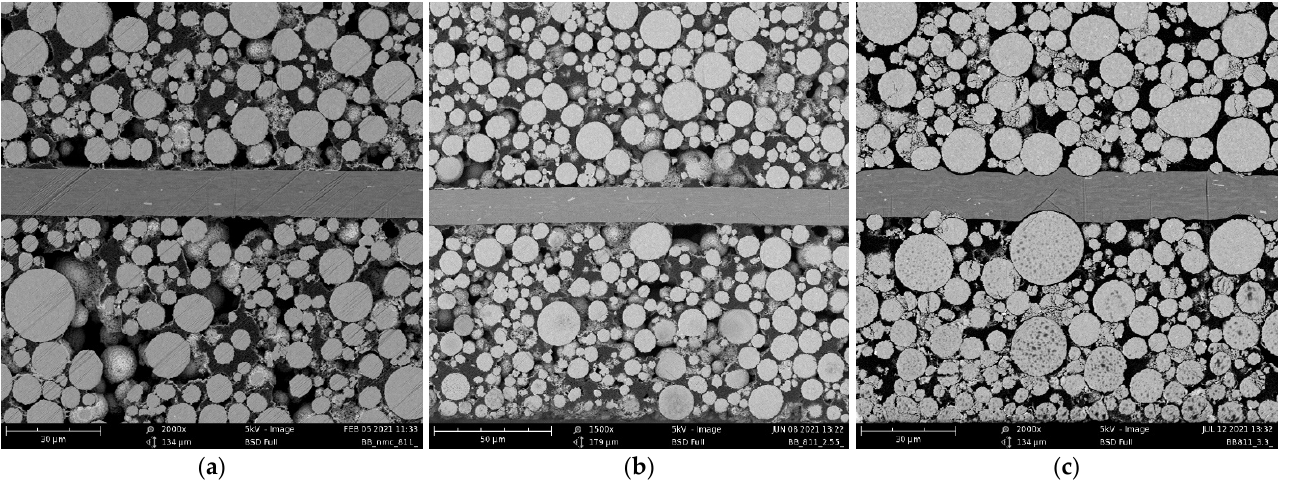
Figure 2. C-rate capability (relative capacity retention) of NMC811 cathodes with varying degrees of densification, tested in a half-cell configuration.